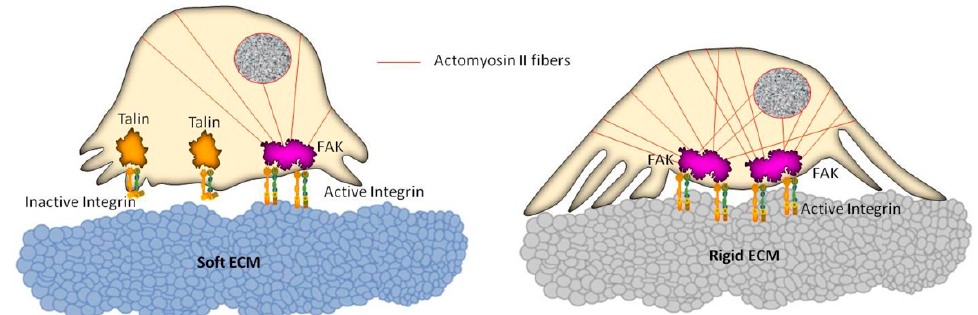
Figure 2. Schematic representation of cell reorganization on soft and rigid extracellular matrix (ECM) substrates. The actomyosin II system connected to focal adhesion complexes generates intracellular contractile forces which are transmitted to the underlying substrate, following a dynamic and mutual information exchange that can lead to changes in cell motility. A soft substrate (left) entails reduced activation of integrins, not allowing the formation of stress fibers within the cell. Conversely (right), a rigid substrate promotes the integrin activation, as well as a remarkable recruitment of actin filaments, leading to a global reinforcement of the cell, thus affecting the cell migration ability.